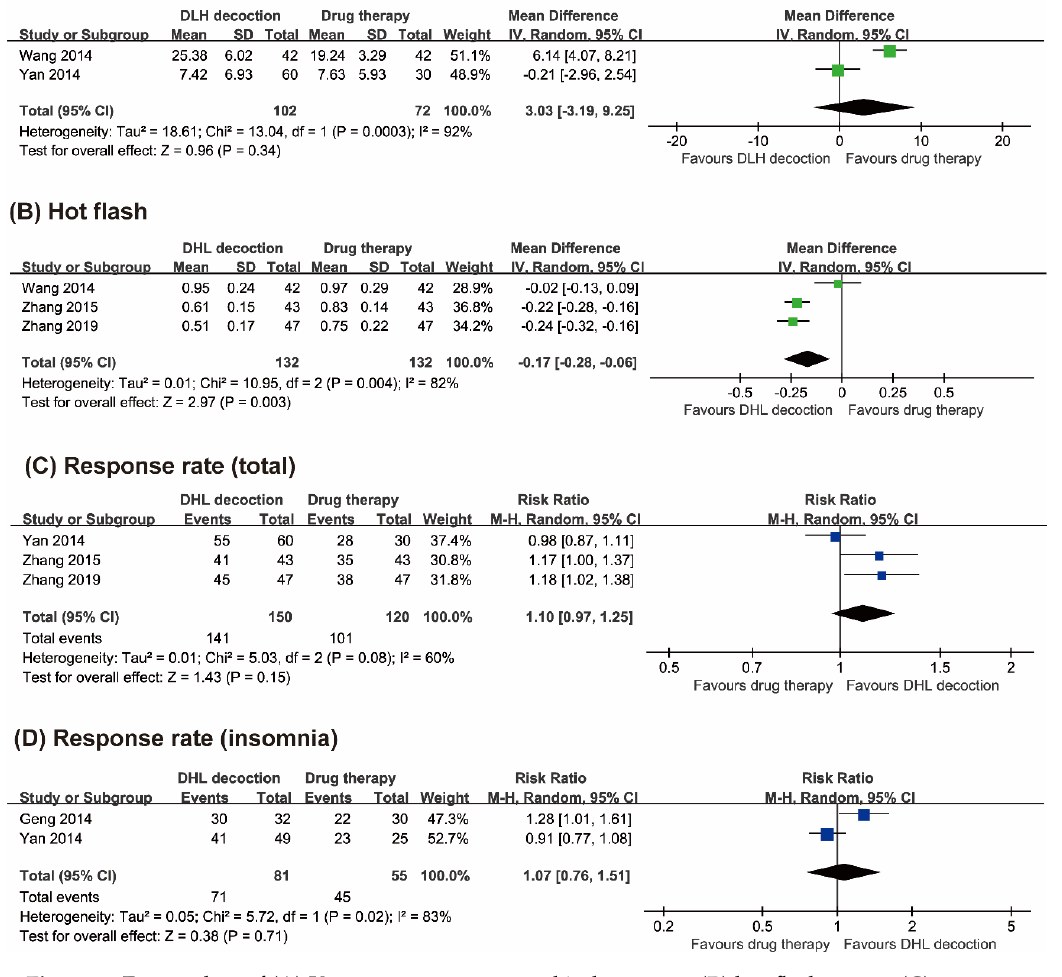
Figure 3. Forest plots of ( A ) Kupperman menopausal index scores, ( B ) hot flash scores, ( C ) response rates (total), and ( D ) response rates (insomnia).